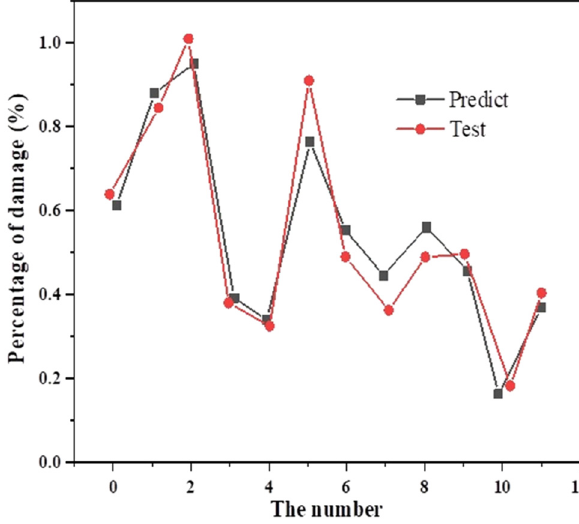
Figure 6: Bridge damage fi t degree at 480 mm.